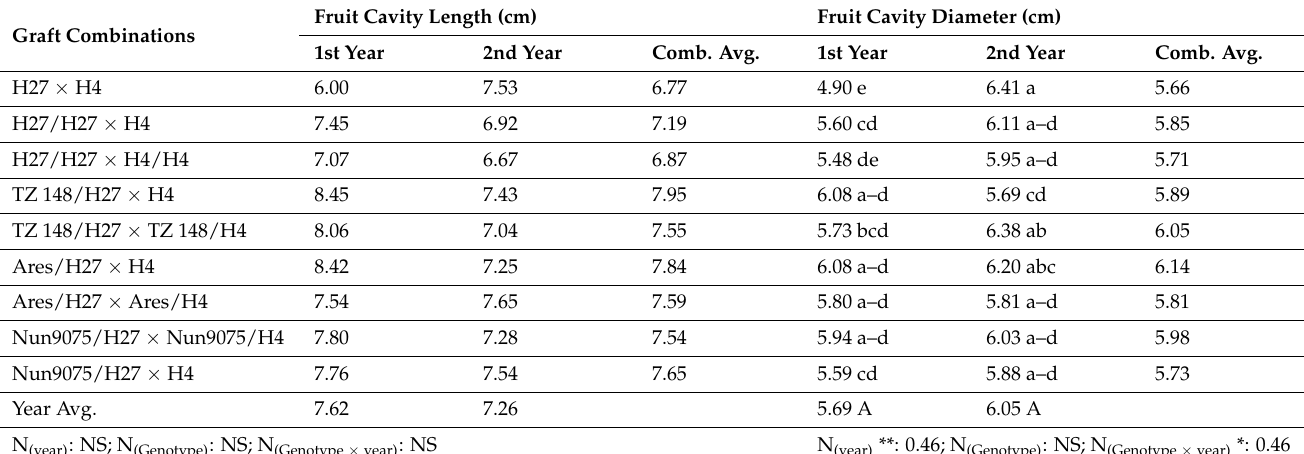
Table 5. Fruit cavity length and fruit cavity diameter of different graft combinations in both years.